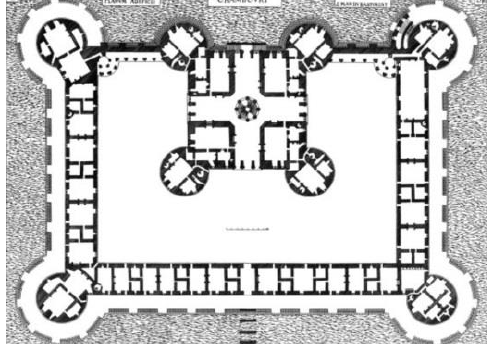
Figure 1: General view of the “ Château de Chambord ”